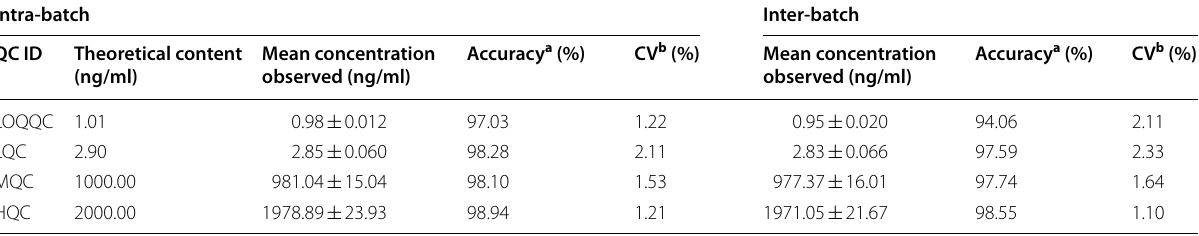
Values (Mean SD) are derived from 6 replicates: ± a Accuracy (%) Mean value of [(mean observed concentration)/(theoretical concentration)] = b Precision (%): coefficient of variance (percentage) 2.90 ng/ml; MQC: 1000 ng/ml; and HQC: 2000